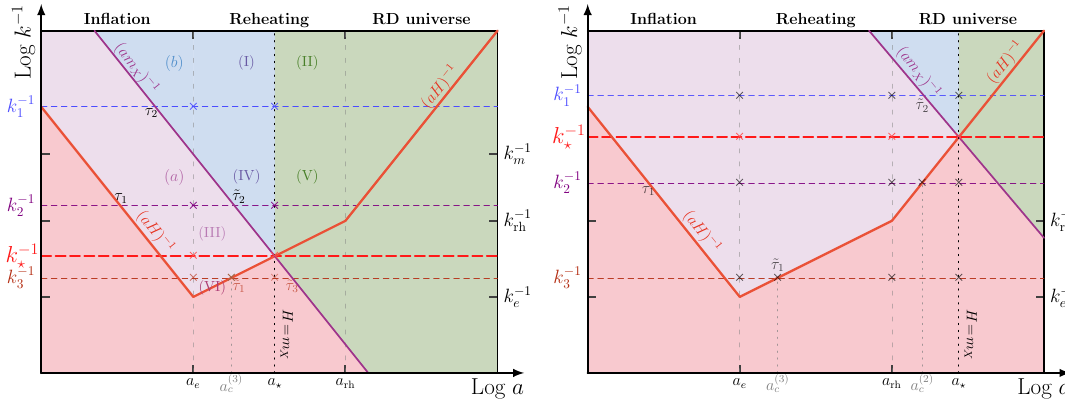
Figure 2 . Evolution of various cosmological distances during and after in(cid:13)ation for heavy vector DM i.e. H rh (cid:20) m X < H I (left diagram) and light vector DM m X < H rh (right diagram). The red region corresponds to modes with wavevector in range am X ; aH (cid:28) k , purple refers to the region where am X < k < aH , blue corresponds to the condition k < am X < aH and in the green region aH; k (cid:28) am X . Here a c = k=H refers to the second horizon crossing , a ? (cid:17) a ( (cid:28) ? ), k m (cid:17) a e m X , k ? = a ? m X , k e (cid:17) a e H I and k rh (cid:17) a rh H rh . The plot assumes (cid:0) 1 = 3 < w < 1 = 3 during the reheating